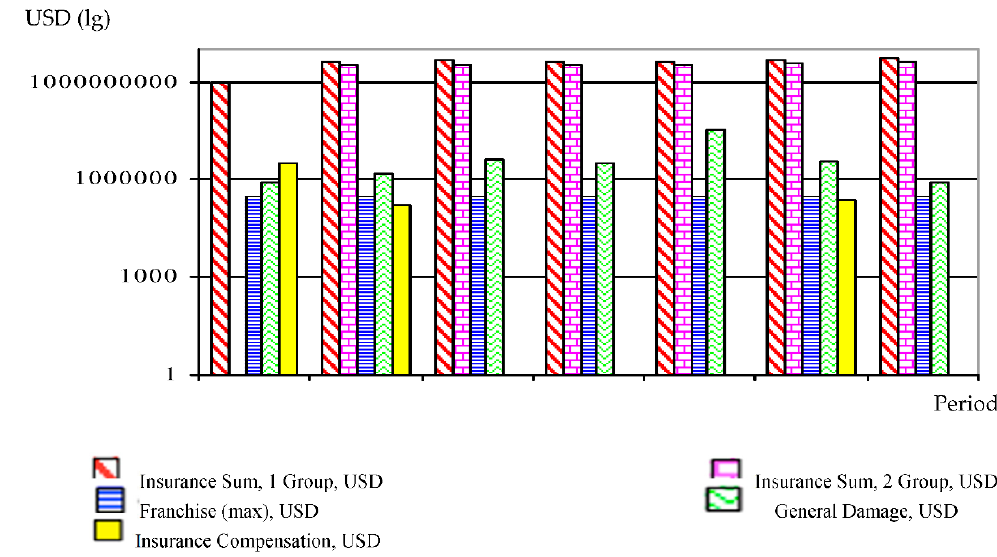
Figure 2. Damage (thousand rubles) depending on the number of incidents (units). Source: authors own design.